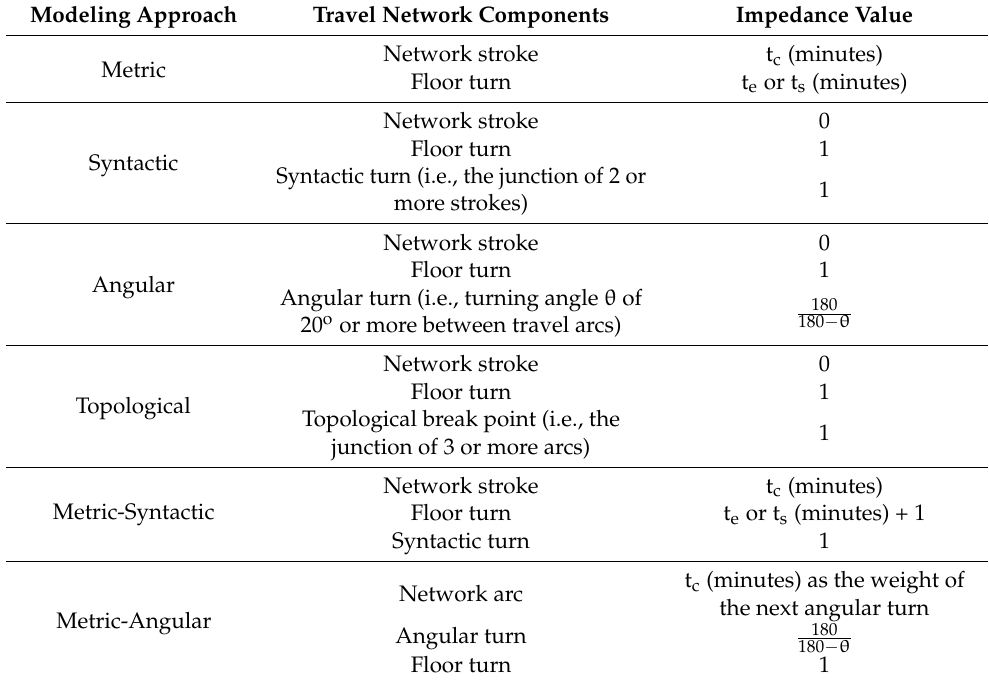
Table 1. Transportation data network components and impedance value for different accessibility evaluation approaches. Modeling